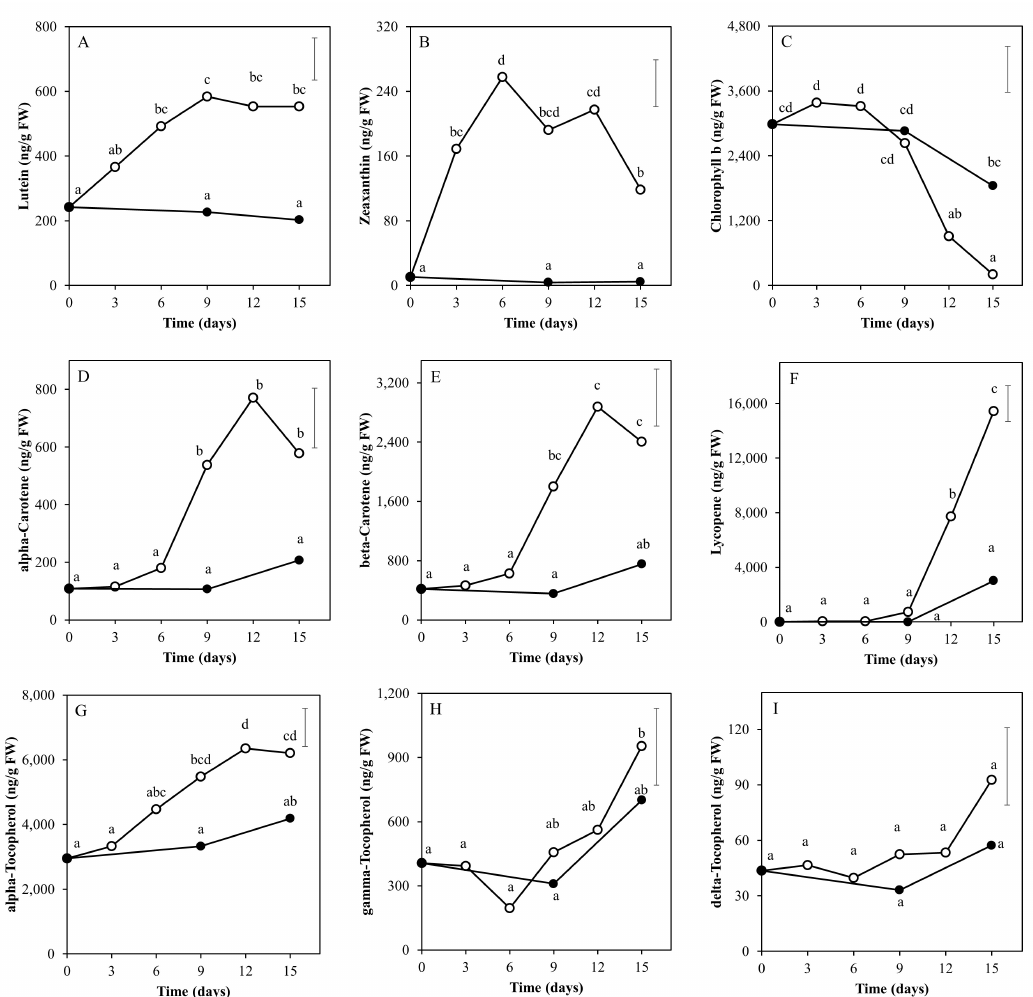
Figure 1. Levels of lipid-soluble metabolites (isoprenoids) in tomato pericarp from experiment 1, measured by LC-PDA-Fl. The fruits were treated with either white light (500 μmol m −2 s −1 ; open symbols) or darkness (closed symbols) for 15 days and sampled at indicated days. Error bars indicate the least significant difference; letters ( A – I ) indicate significant differences between treatments or days at α = 0.01, n = 3 (3 pools of 2 fruits each).